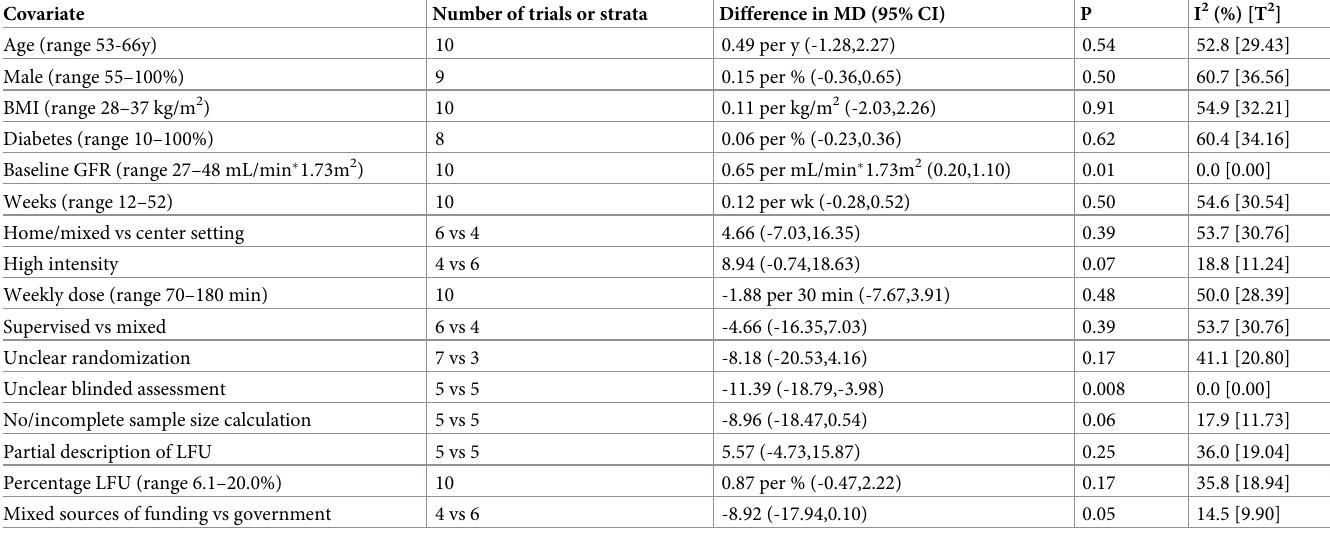
BMI body mass index, CI confidence interval, GFR glomerular filtration rate, LFU lost to follow-up, MD difference in means, SBP systolic blood pressure All categorical covariates had � 3 trials or strata in each